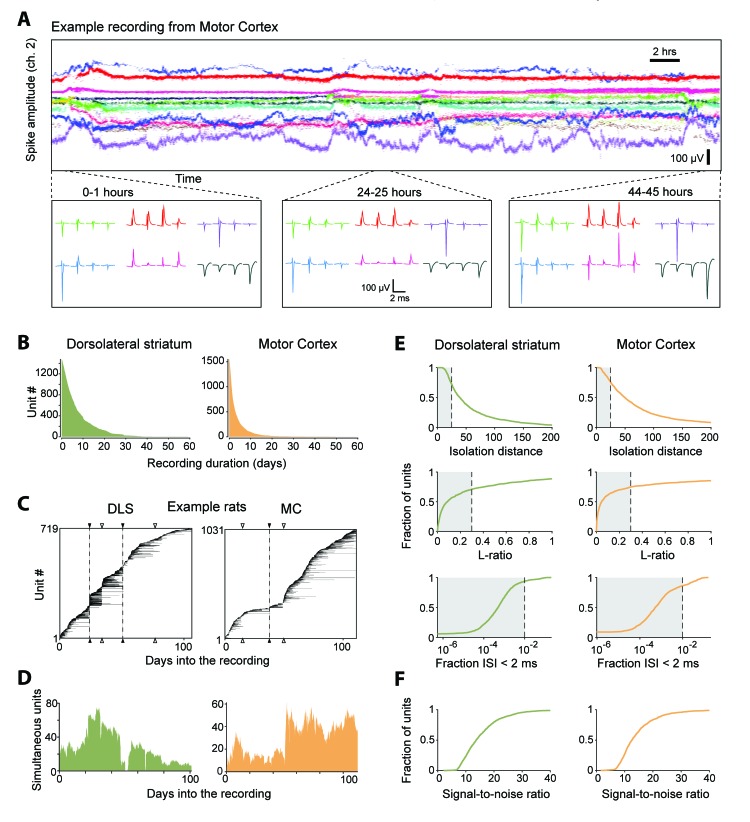
Single units isolated and tracked from continuous months-long recordings made in dorsolateral striatum (DLS) and motor cortex (MC) of behaving rats.(A) The results of applying FAST to a representative continuous tetrode recording in the rodent motor cortex spanning 45 hr. Each point represents spike amplitudes on channel 2 of a tetrode, with different colors representing distinct units. For visual clarity we have plotted the amplitude of de-noised spike centroids (see Figure 2), not raw spike amplitudes. Insets (bottom) show average spike waveforms of six example units on the four channels of the tetrode at 0, 24 and 44 hr into the recording. (B) Holding times for all units recorded in the DLS (left, green) and MC (right, orange), sorted by duration. (C) Temporal profile of units recorded in DLS (left) and MC (right) from two example rats over a period of ~3 months. Unit recording times are indicated by black bars, and are sorted by when they were first identified in the recording. Black triangles and dotted lines indicate times at which the electrode array was intentionally advanced into the brain by turning the micro-drive. Open triangles indicate times at which the population of recorded units changed spontaneously. Number of simultaneously recorded units in the DLS (left, green) and MC (right, orange) as a function of time in the two example recordings. (D) Number of simultaneously recorded units in the DLS (left, green) and MC (right, orange) as a function of time in the example recordings shown in C. (E) Cumulative distributions of average cluster isolation quality for all units recorded in DLS (left, green) and MC (right, orange). Cluster quality was measured by the isolation distance (top), L-ratio (middle), and fraction of inter-spike intervals under 2 ms (bottom). Dotted lines mark the quality thresholds for each of these measures. Shaded regions denote acceptable values. (F) Cumulative distributions of average signal-to-noise ratios for all units recorded in DLS (left, green) and MC (right, orange).